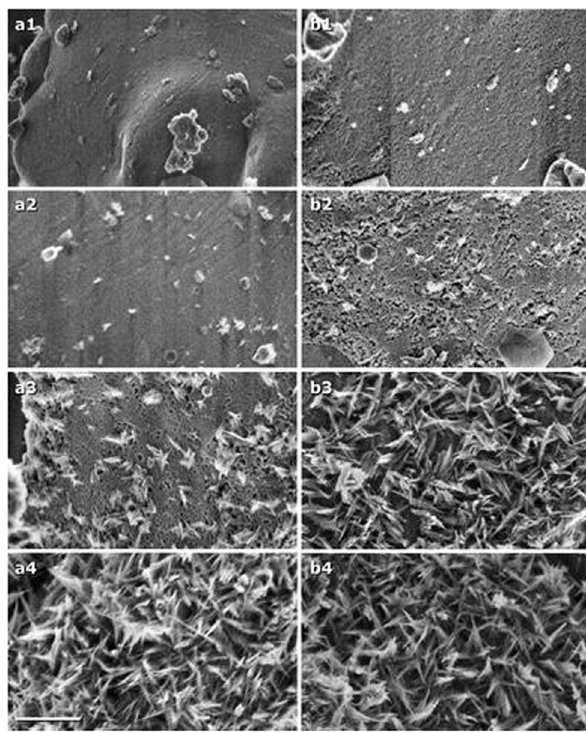
Figure 13: SEM micrographs of the evolution of the surface of C 3 S at various hydration times. Series ( a ) ( control sample ) : a1: 20 min; a2: 1 h 20 min; a3: 2 h 30 min; and a4: 7 h. Series ( b ) ( C 3 S in the presence of synthetic C - S - H [ C/S = 0.8 ]) : b1: 10 min; b2: 1 h; b3: 3 h; and b4: 10 h. The white scale bar indicates 500 nm [ 70 ]